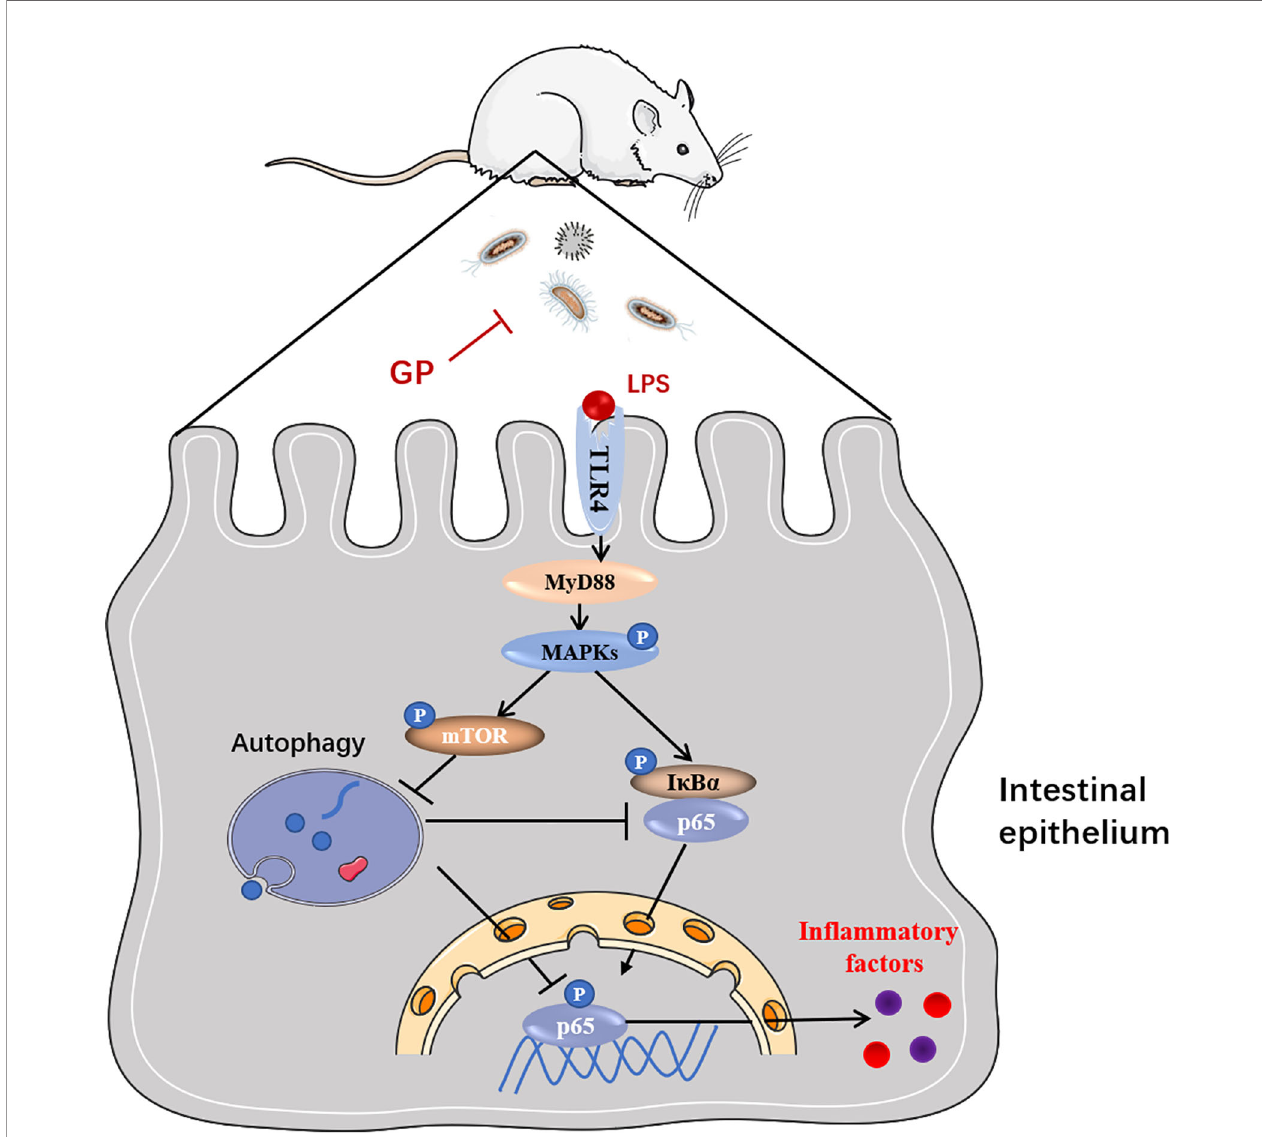
FIGURE 9 | Schematic representation of the proposed mechanism of GP on ameliorating intestinal in fl